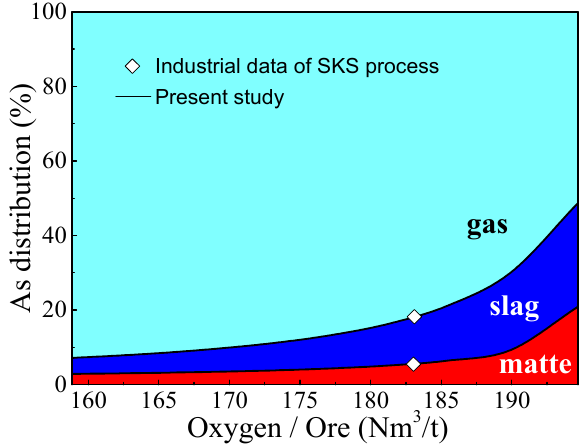
Figure 11. Effects of the ratio of oxygen/ore on arsenic distribution in SKS process.